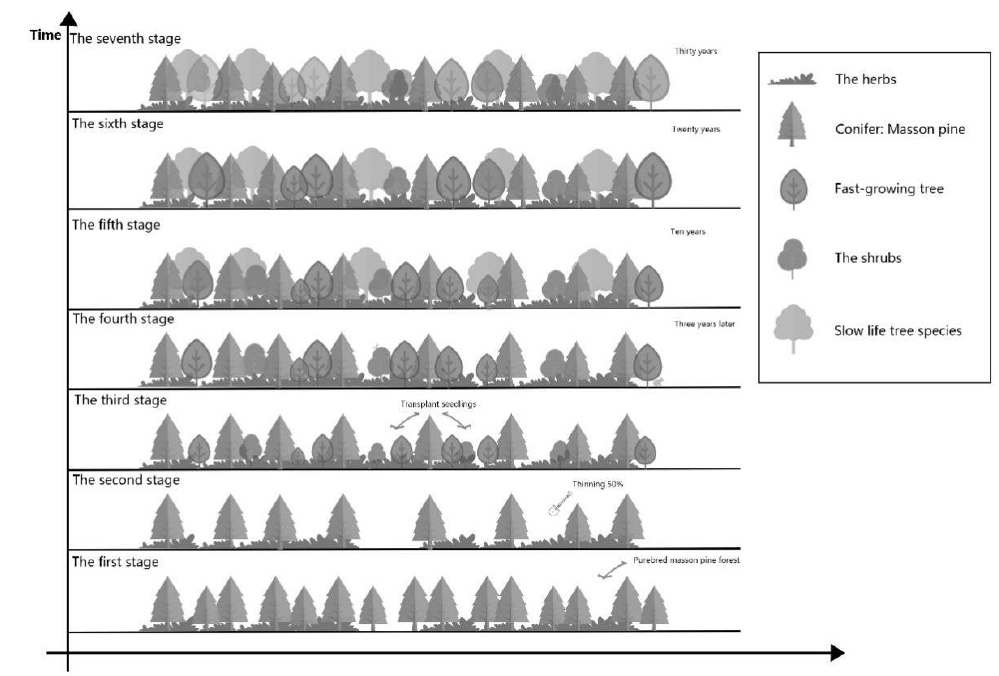
Figure 11. The process of community renewal in South Lake Scenic Area .